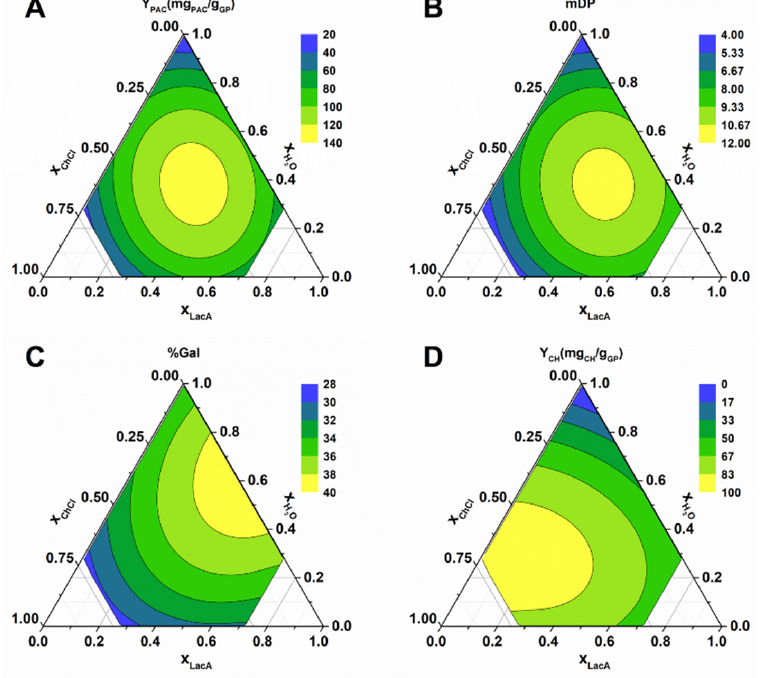
Figure 4. Contour plots obtained for solvent composition optimization of ChCl:LacA. ( A ) Y PAC ; ( B ) mDP; ( C ) %Gal; ( D ) Y CH .